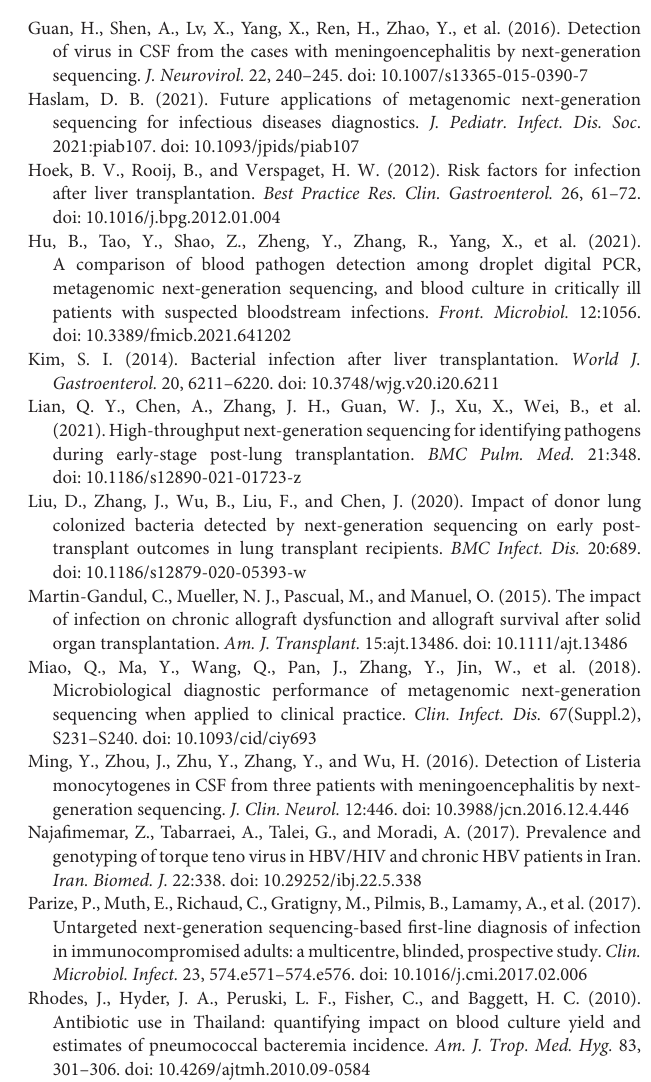
Supplementary Table 1 | Baseline characteristics of patients in this study. Supplementary Table 2 | Metagenomic next-generation sequencing and culture results of the whole 122 samples in this study. Supplementary Table 3 | Survival of patients who did not receive